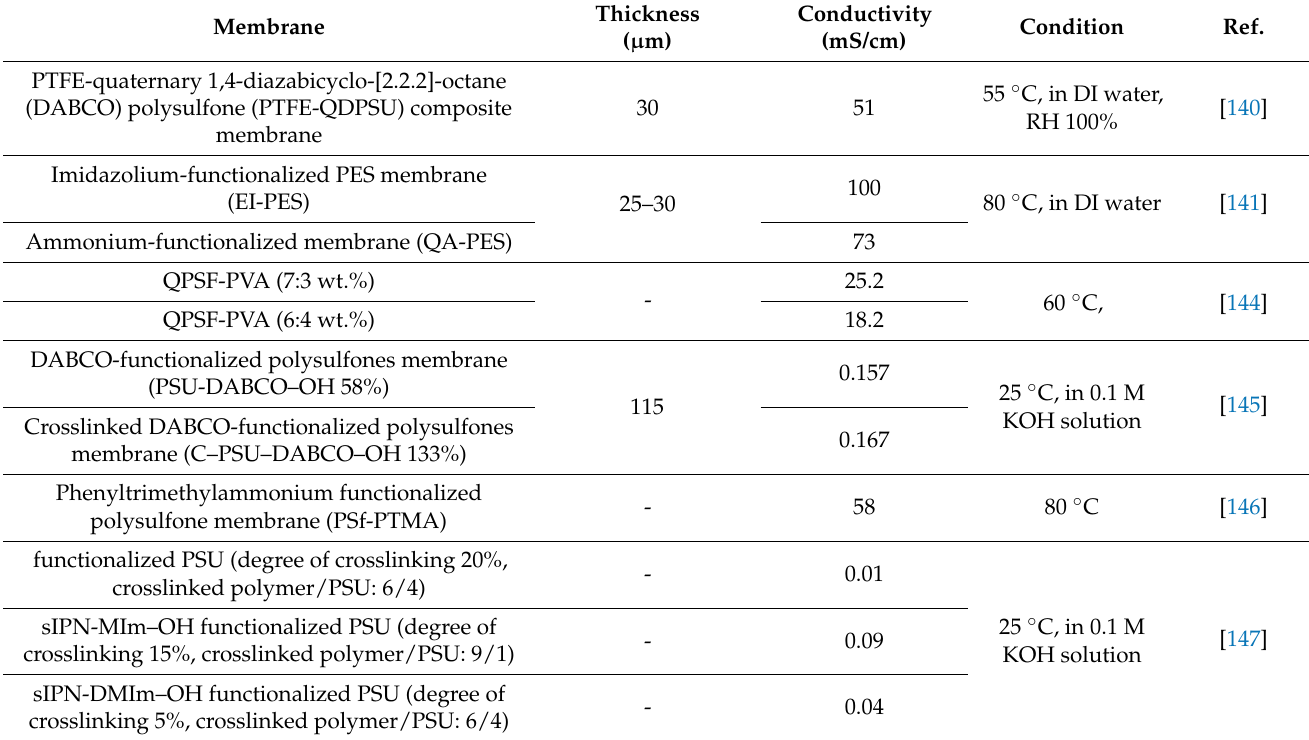
Table 6. Ionic conductivity of PS-based